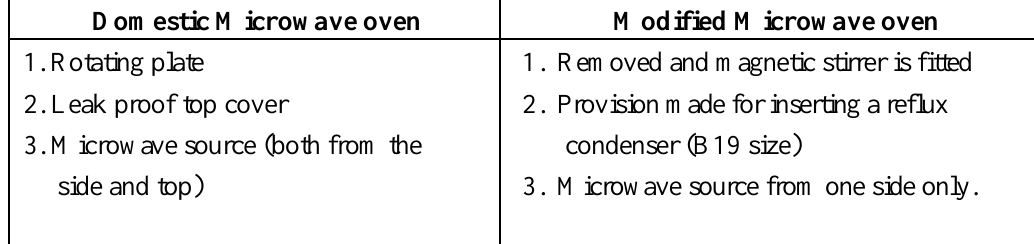
Table 4 . Modifications effected in the domestic microwave